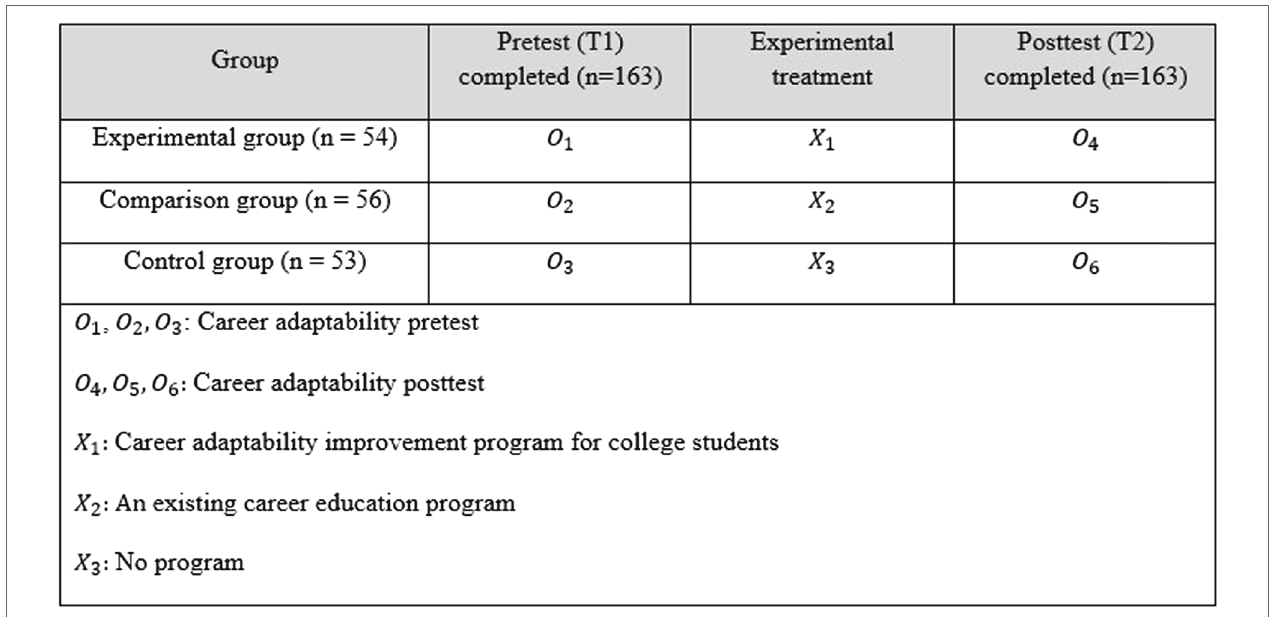
FIGURE 2 | Experimental design for program effectiveness